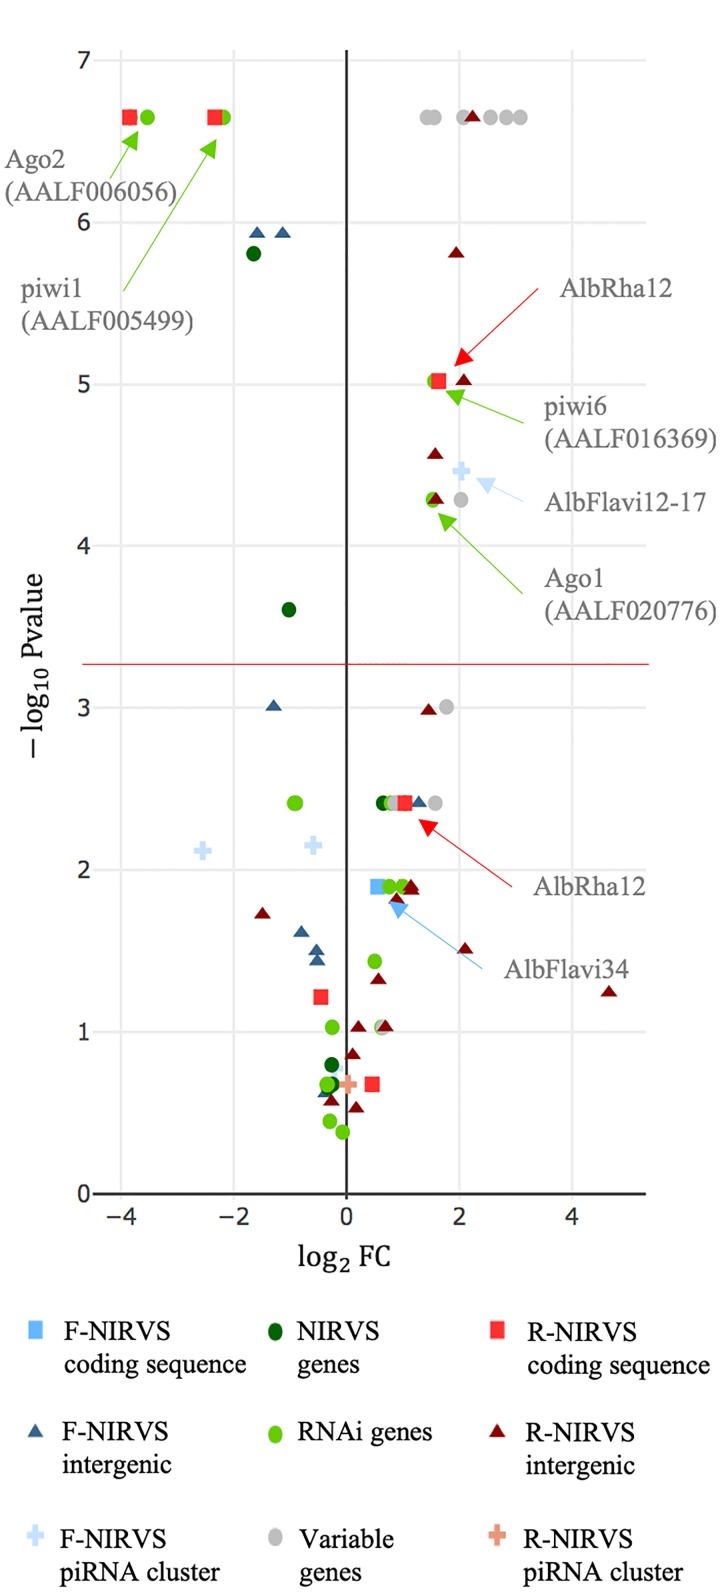
NIRVS polymorphism. Volcano plot showing LoP comparison between SGs and NIRVS, genes encompassing NIRVS (Palatini et al., 2017), genes of the RNAi pathway and FGs. Entities with LoPs statistically different than that of conserved genes are above the red line [adjusted significance of the test (–log10 0.05/99 = 3.32)]. Entities on the left side of the panel (log2FC < 0) have smaller LoP than conserved genes. The opposite for entities on right side of the panel (log2FC > 0).